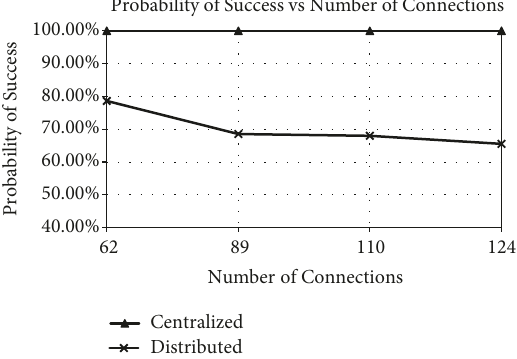
Figure 15: Probability of success vs number of connections in Germany